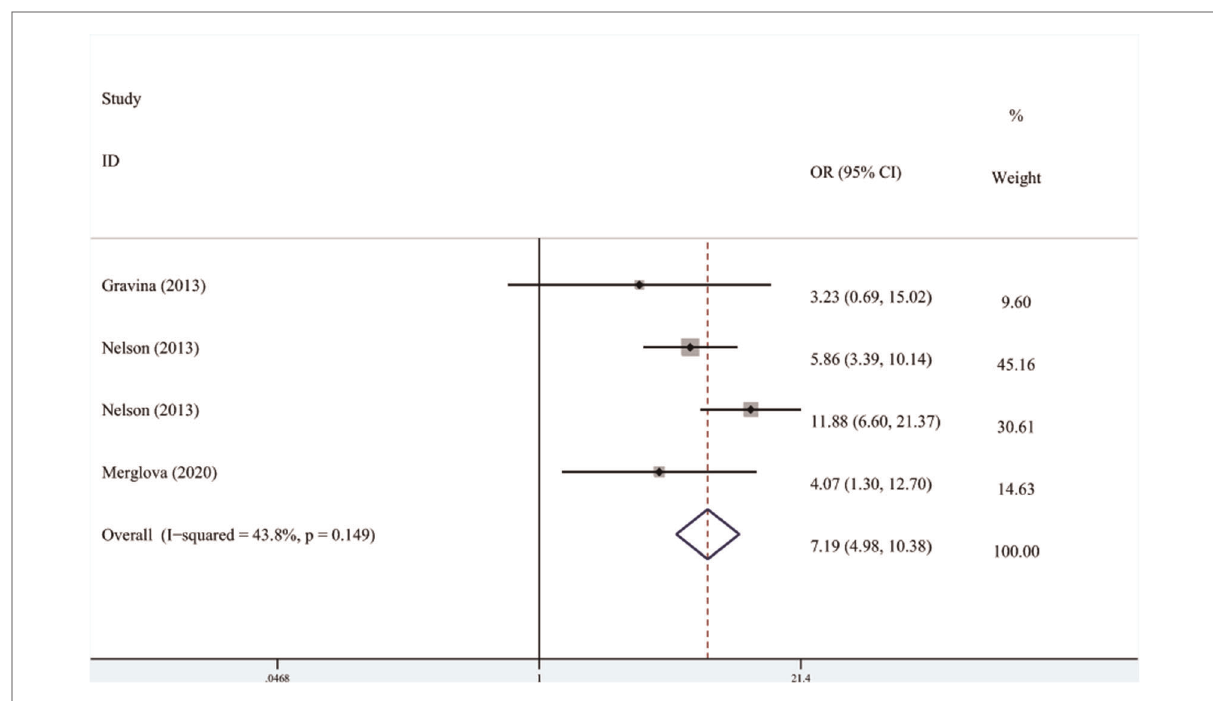
FIGURE 4 The forest plot shows the relationship between VLBW and DDE (FEM). VLBW, very low birth weight; DDE, developmental defects of enamel.